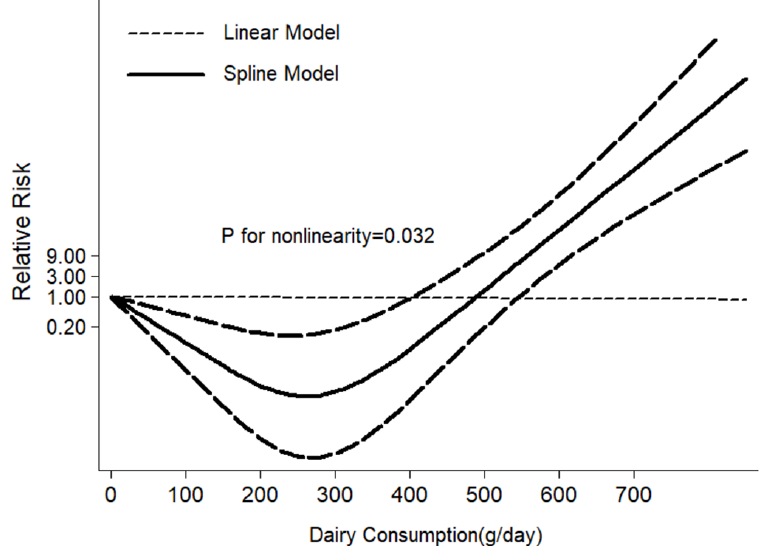
Figure 2. Non-linear dose–response relationship between daily intake of total dairy and T2DM risk of the meta-analysis.